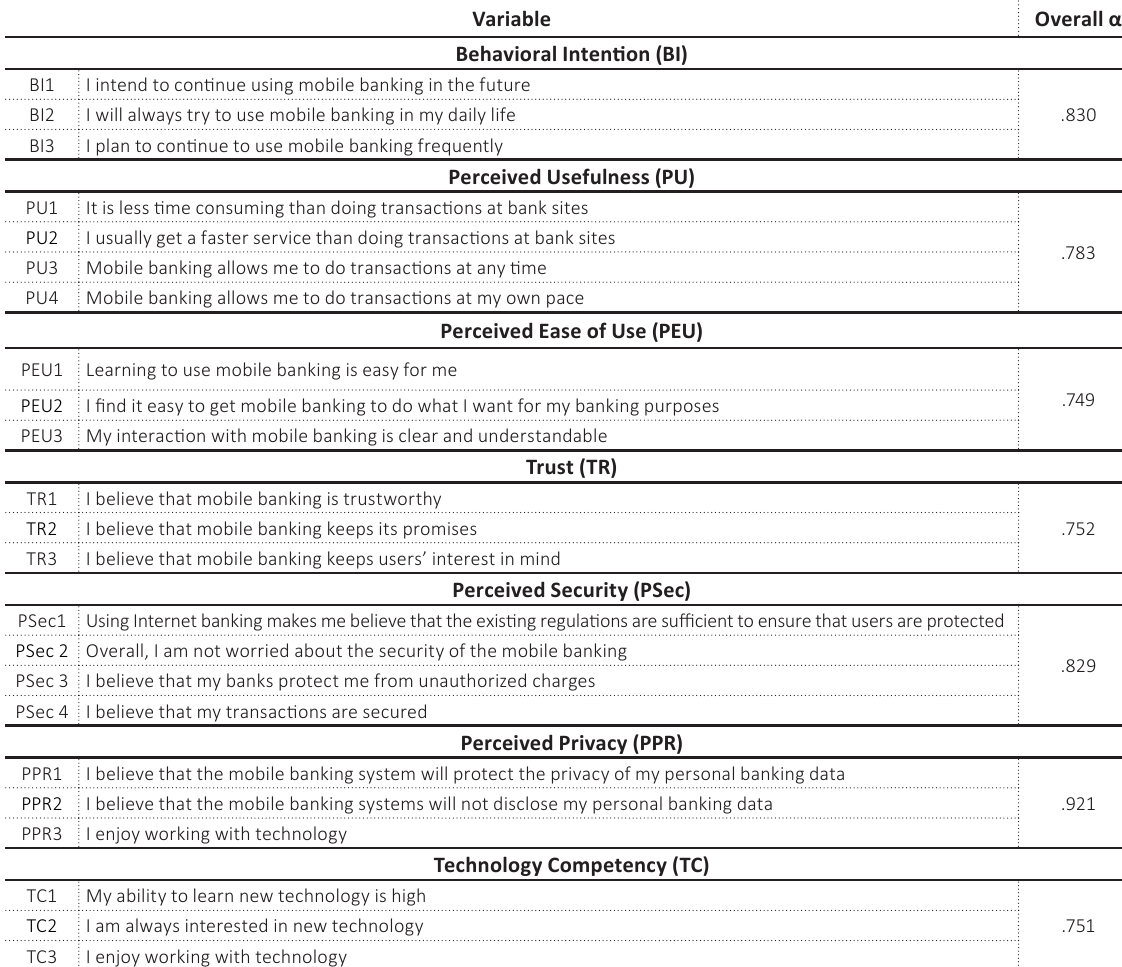
Table 2. Item wise of the Cronbach Alpha ( α )